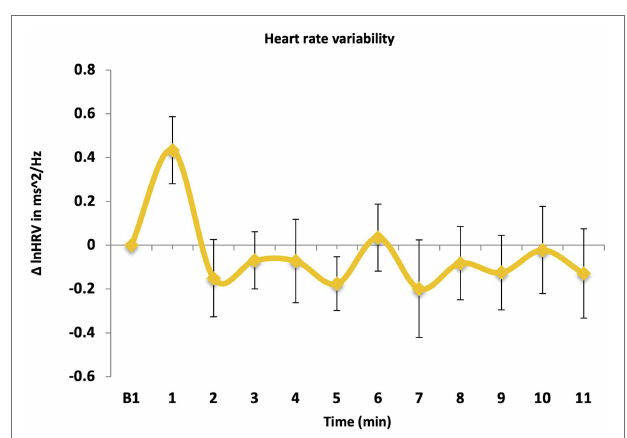
FIGURE 4 | Skin conductance (SCL) response over time.